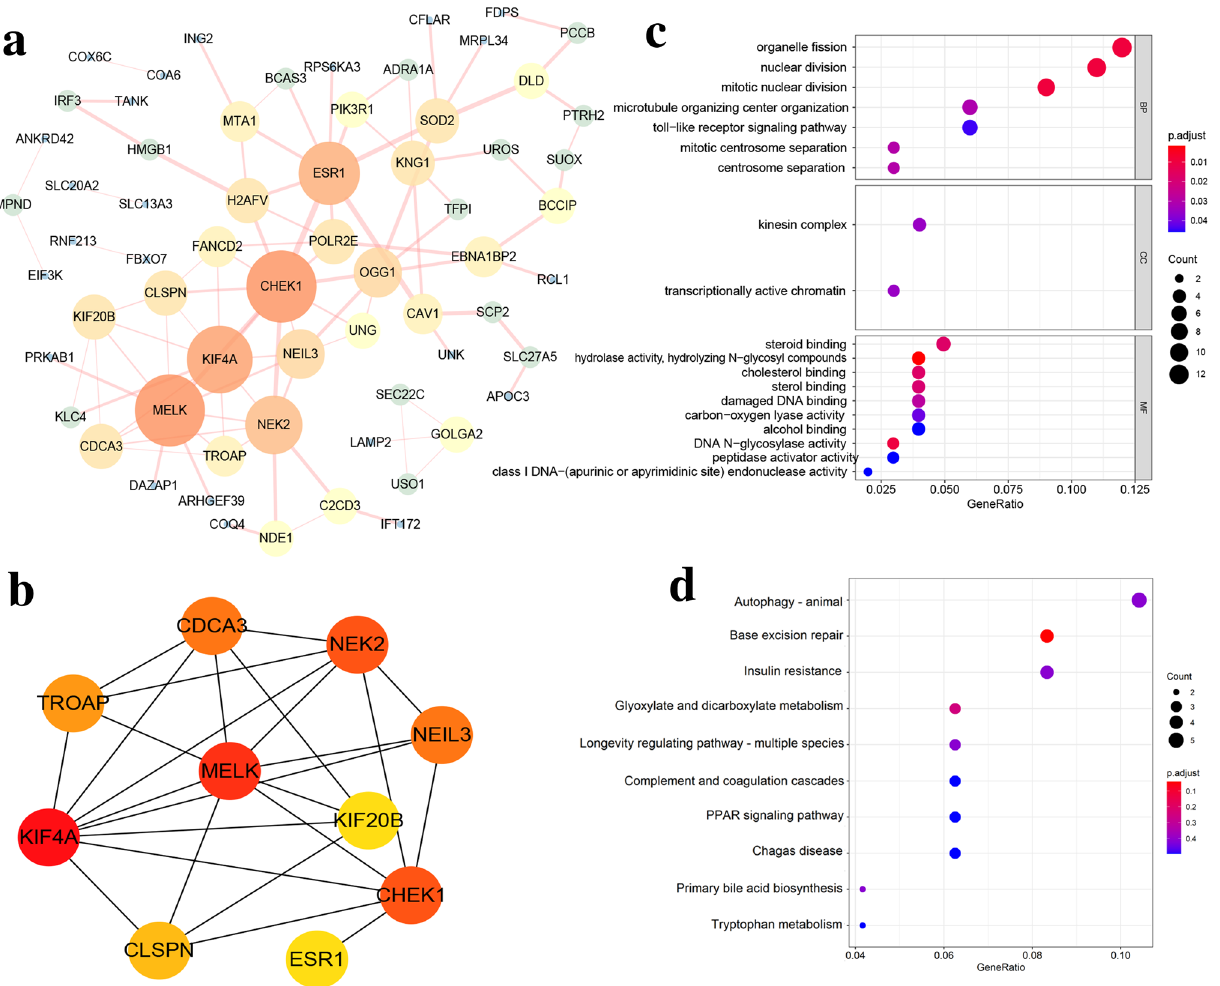
Figure 8. Functional exploration of AS events regulated by SFs in the prognostic model. ( a ) PPI network of 108 protein-coding genes of AS events involved in the SFs-AS events regulatory network. ( b ) The PPI network of the top 10 hub genes. ( c ) GO categories (BP, CC, and MF) enriched by above 108 protein-coding genes. ( d ) Top 10 KEGG pathways enriched by above 108 protein-coding genes. For ( c,d ), the size and color of nodes represent the number of enriched genes and adjusted P